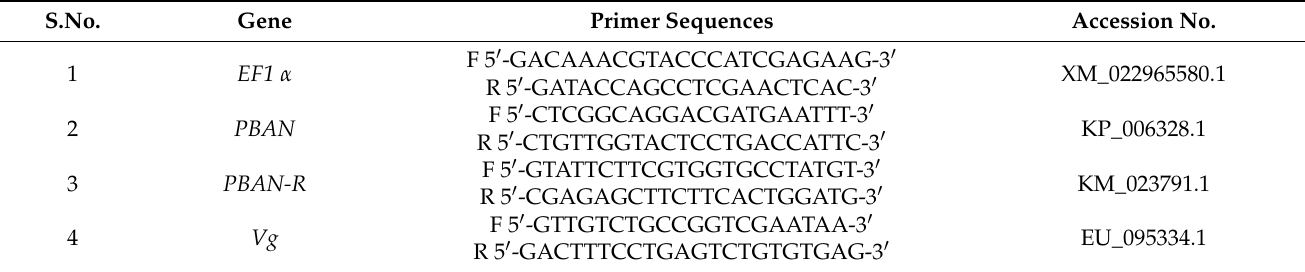
Table 1. Details of primer sequences used for the quantitative real time PCR (qPCR).